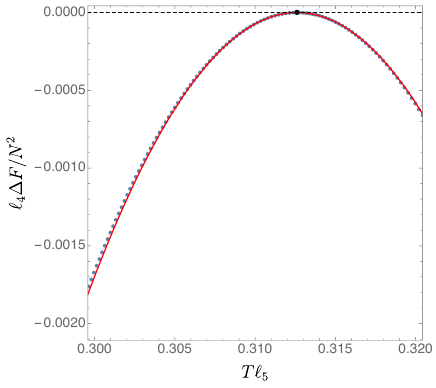
Figure 14 . Free energy of the fat and thin funnels as a function of T‘ 5 computed near the merger point: the red solid line corresponds to the nonlinear perturbative result (3.24) and the blue disks to our exact numerical data. The agreement between the two methods is